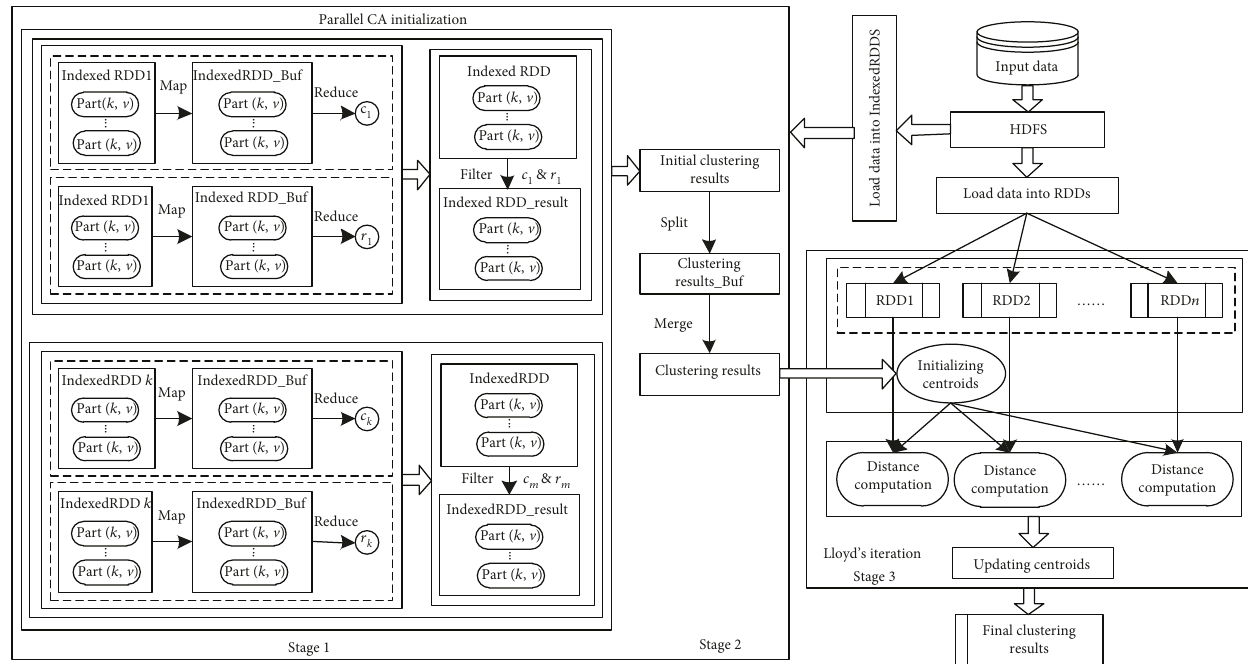
Figure 3: Overall procedure of the parallel C- K -means